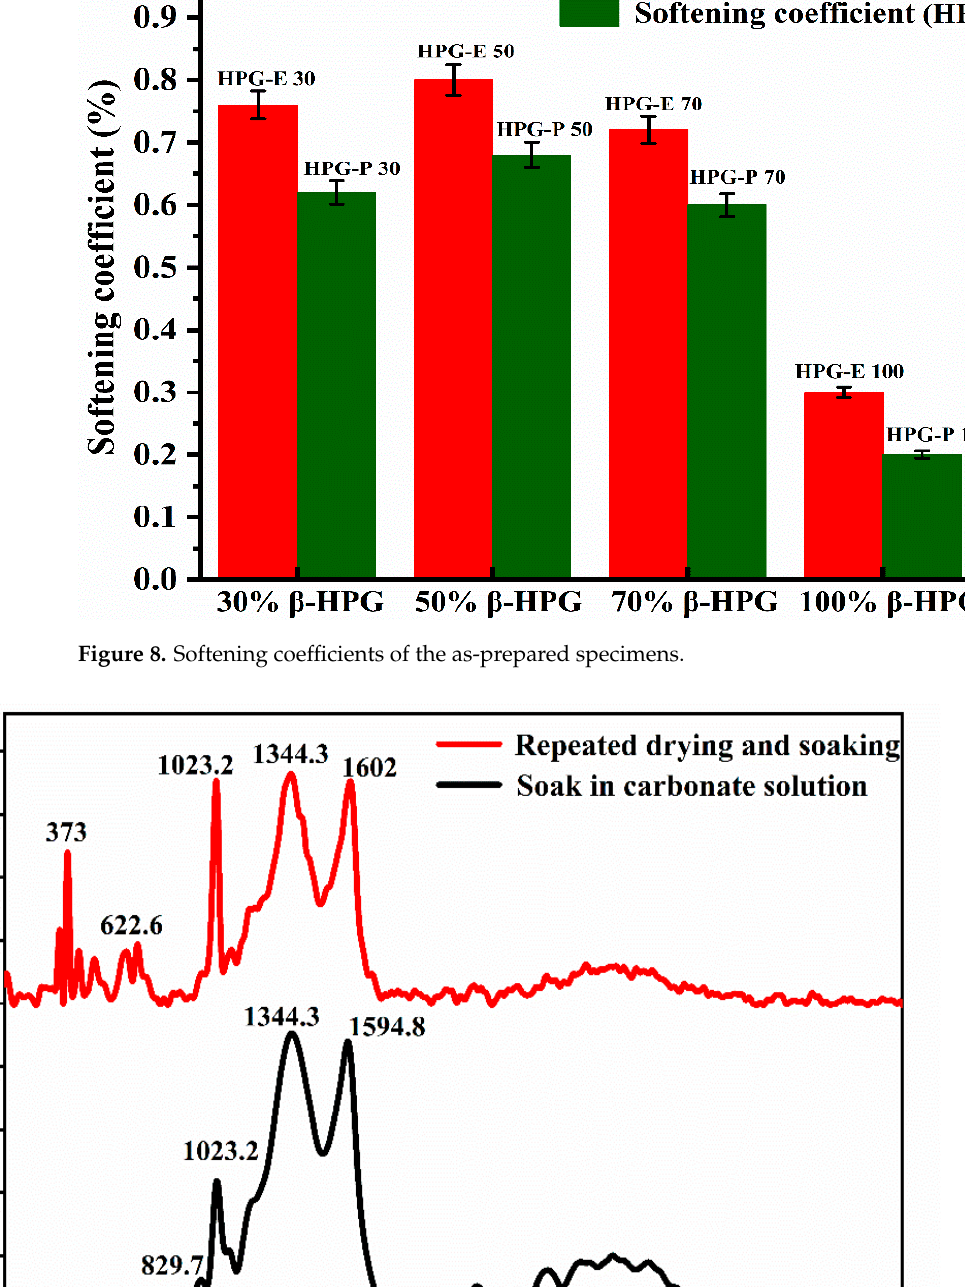
Figure 7. Water absorption properties of the as-prepared specimens.